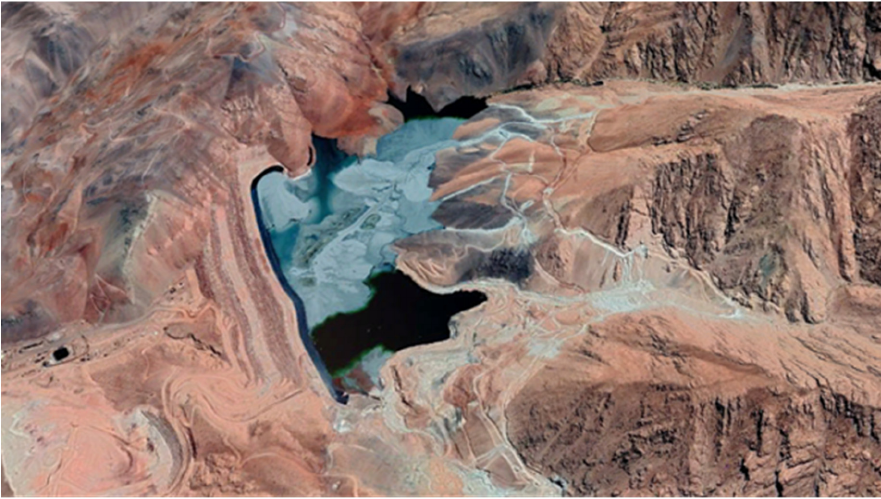
Figure 11. Slimes Storage Facility (Cycloned Fine Tailings) SSSTT—Caserones Mine, Chile [18].